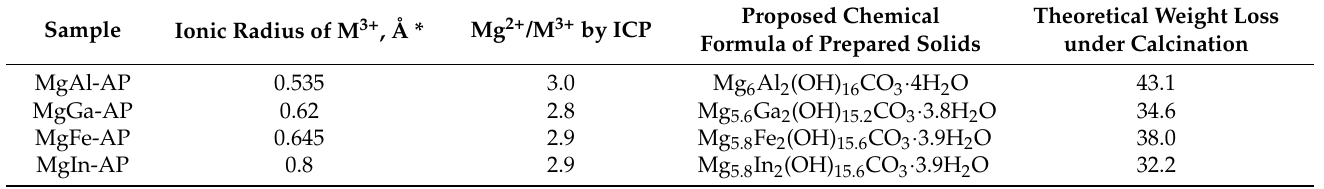
Table 1. Mg/M 3+ atomic ratios in the as-prepared samples according to ICP results and the proposed HTC formula. Sample